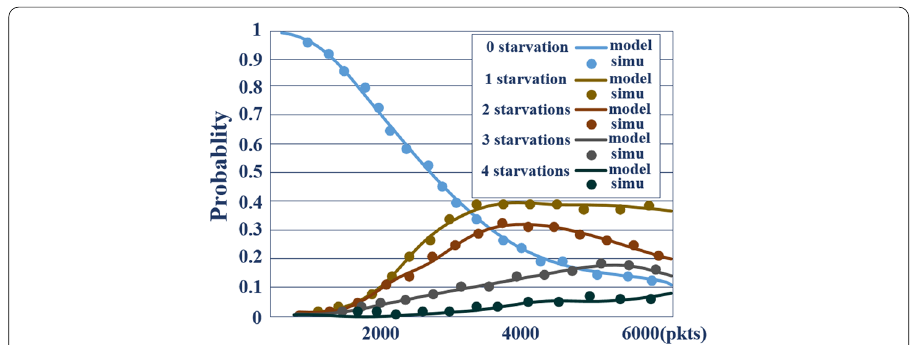
Fig. 6 Probability of 0–4 starvations with